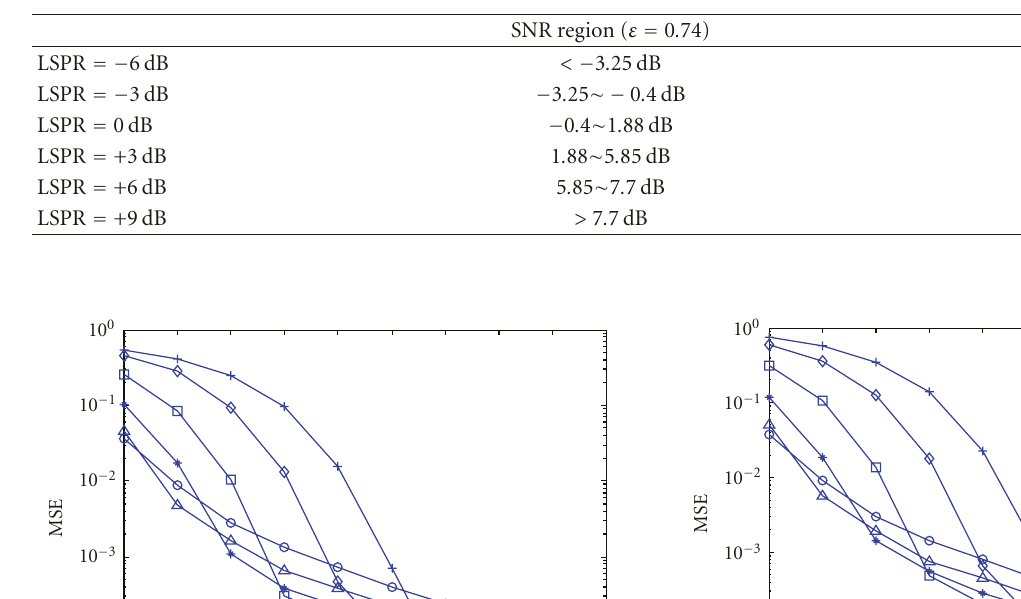
Table 4: Relation of SNR region condition and corresponding optimized LSPR parameters ( ε = 0 . 74, ε = 0 . 246).